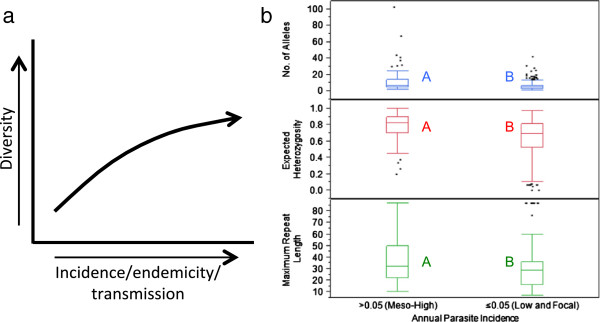
a, b MS diversity is a function of parasite endemicity. (a) Schematic illustrating that population diversity increases as a function of increased endemicity, captured by parasite incidence and transmission; (b) for all MS markers combined, the box plots compare the mean number (no) of alleles per locus (y-axis, blue), expected heterozygosity (He) (y-axis, red) and maximum repeat length (y-axis, green) between different API categories (x-axis). Character values (A and B) denote statistical significance between API strata (p <0.0001, ANOVA).